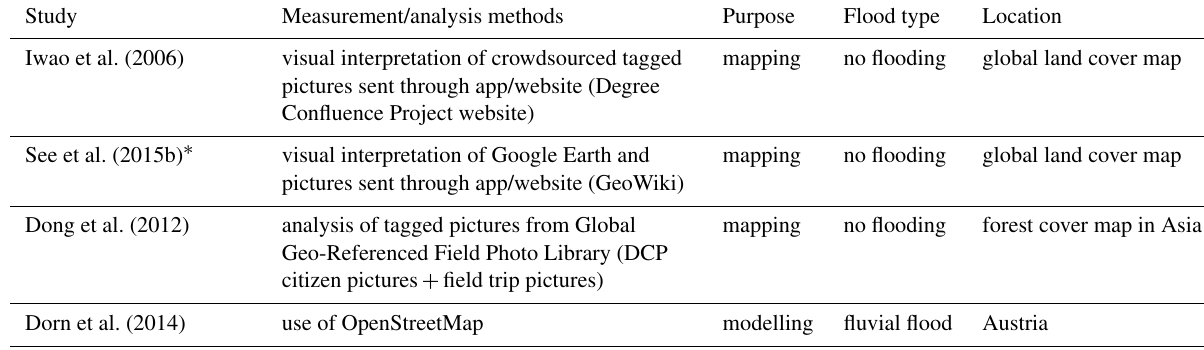
Table 4. Scientific literature on citizen contributions to measurement and analysis of land cover/land use.